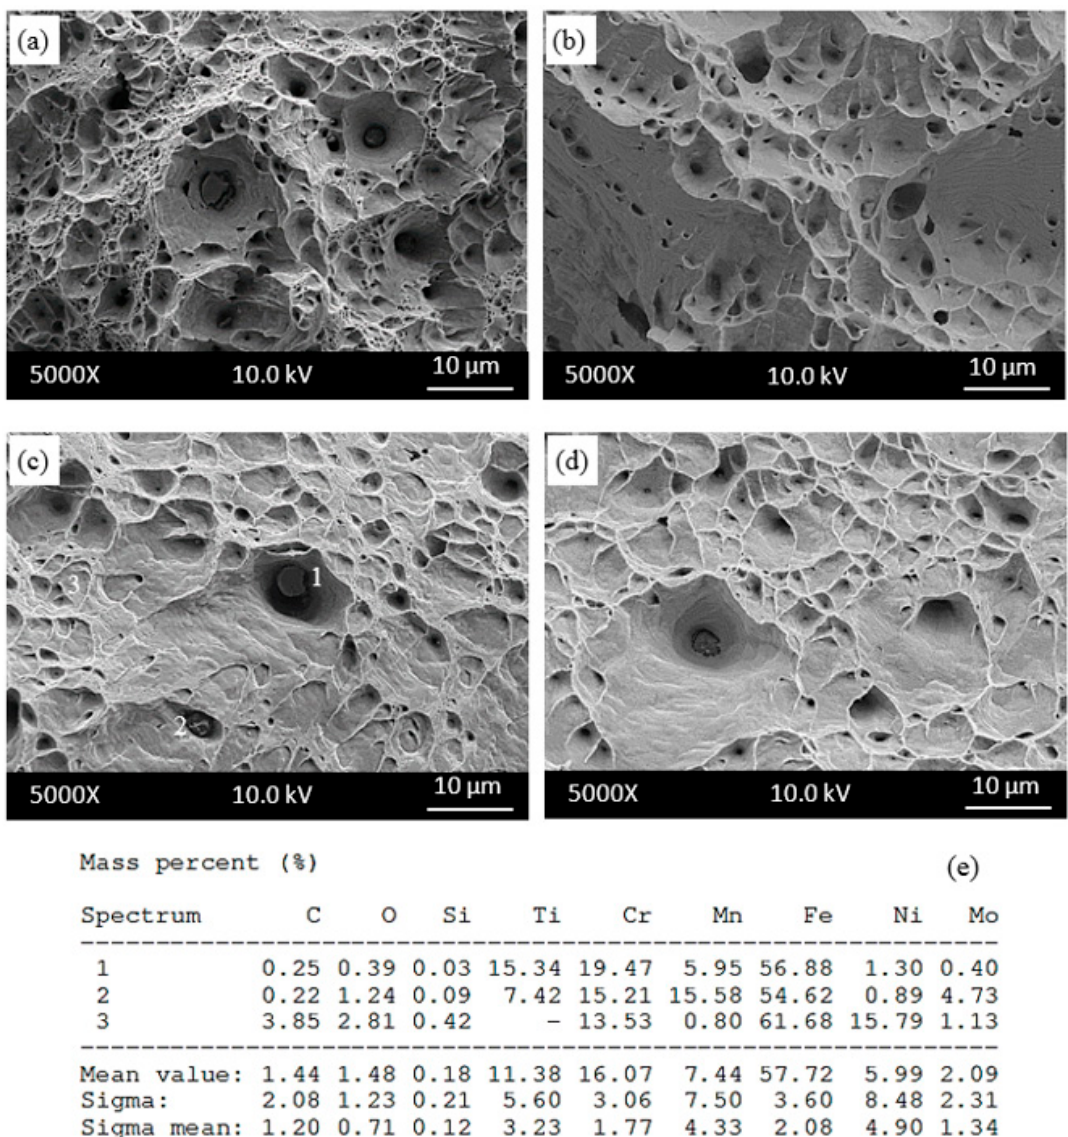
Figure 10. Fractography of as-received samples tested at ( a ) 25 °C, ( b ) 200 °C, ( c ) 400 °C and ( d ) 600 °C and ( e ) corresponding energy dispersive spectrometry (EDS) of the indicated particles in samples tested at 400 °C.